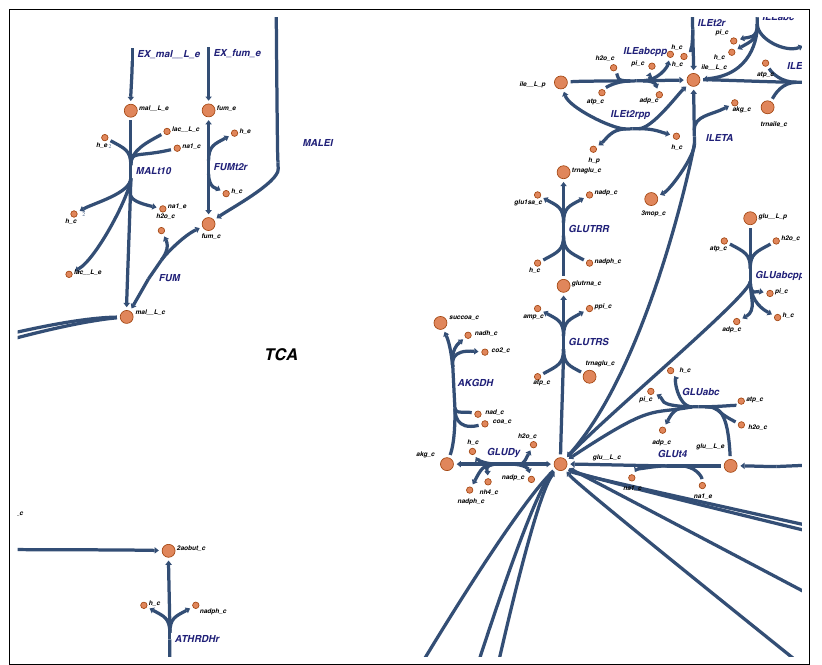
Figure 3. Missing TCA cycle in D. pigrum . As predicted by Brugger et al., D. pigrum does not have a tricarboxylic acid (TCA) cycle but only two associated reactions. The two reactions are the fumarate- hydratase (FUM) and the TCA-associated dihydrolipoyl dehydrogenase (AKGDH). The map was drawn using Escher [63]. See the Supplementary Materials for a complete